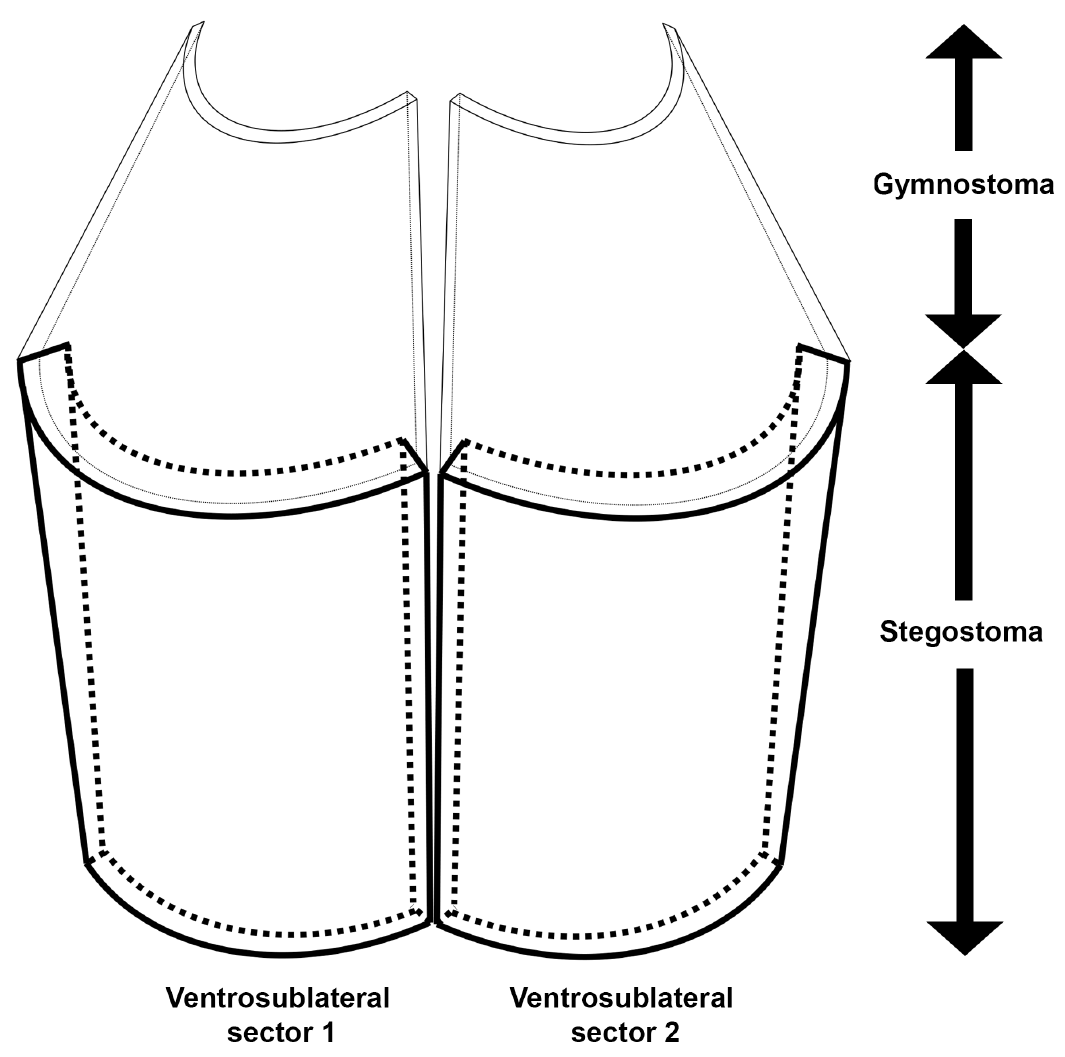
Fig. 5. Schematic representation of buccal cavity wall cuticularization in Halanonchus based on observations of Halanonchus scintillatulus Leduc sp. nov. and illustrations of other Halanonchus species. Only the two ventrosublateral sectors are shown (dorsal sector omitted for clarity). Thin lines show contours of gymnostoma, and thick lines show contours of